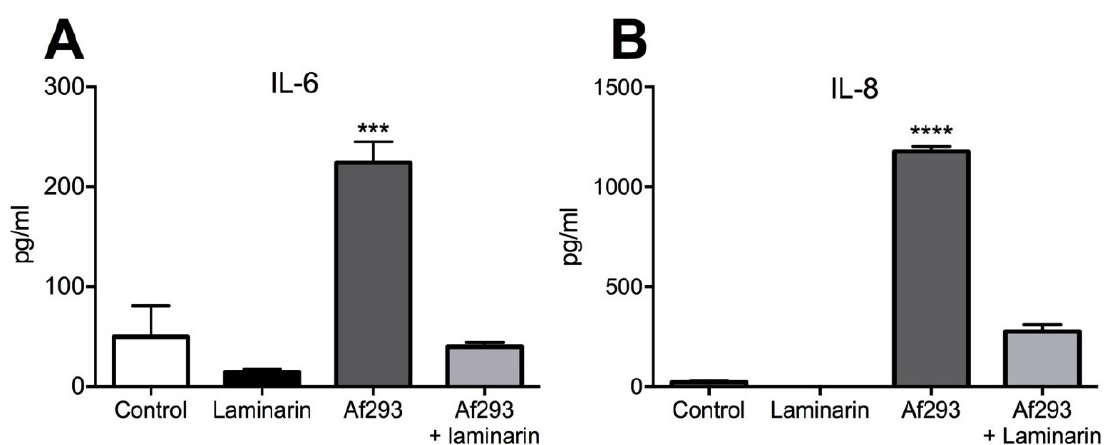
Figure 6. Dectin-1 receptor antagonism inhibits the induction of proinflammatory cytokines. Addition of a Dectin-1 receptor inhibitor, laminarin, to conidia (Af293)-exposed cells for 24 h significantly reduced ( A ) IL-6 and ( B ) IL-8 levels compared with the no laminarin conidia-exposed control. Data represent mean +/ − SEM; one-way ANOVA with Bonferroni multiple comparison test. **** p < 0.0001, *** p < 0.001 compared with the control.